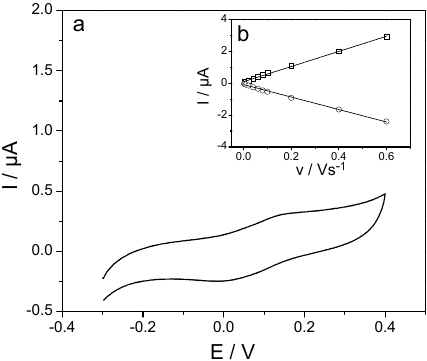
Figure 1. ( a ) Cyclic voltammogram of screen-printed carbon electrode modified with 3,4DHS capped gold nanoparticles (3,4DHS–AuNP/SPCE) in 0.1 M phosphate buffer (pH 7) at 0.04 V·s − 1 ; The inset ( b ) shows the dependence of the anodic and cathodic peak current on the scan rate.